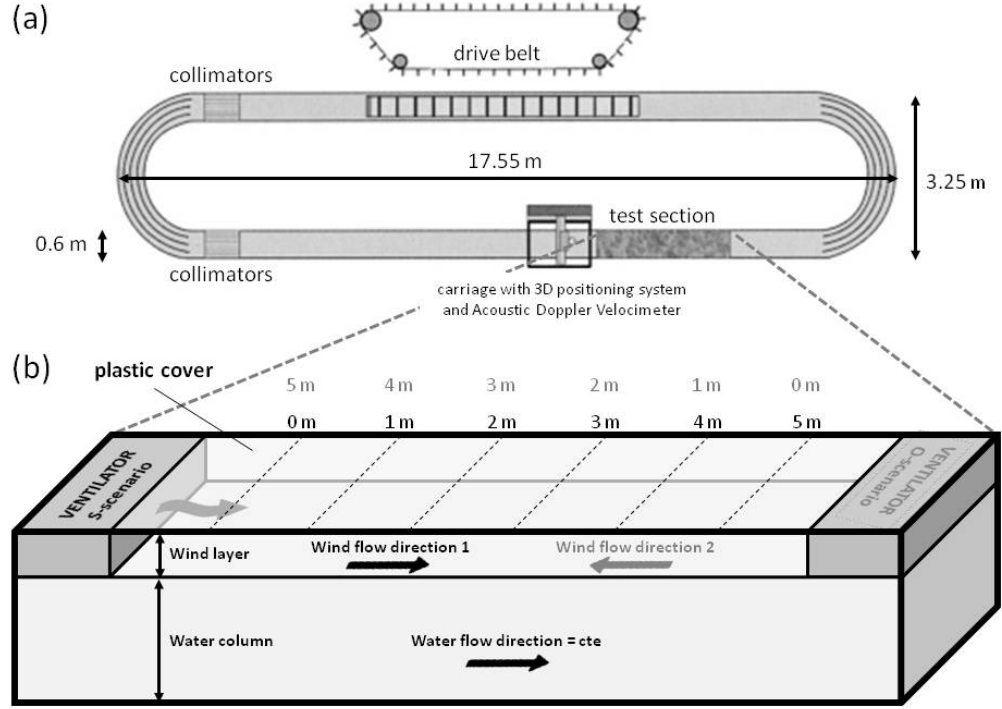
Fig. 1. Schematic representation of (a) the racetrack flume (modified from Bouma et al., 2005) and (b) a detailed depiction of the experimental flume section. (b) The position of the ventilator is indicated in dark grey (left: S-scenario; right: O-scenario). The wind flow direction 1 represents the S-scenario (black arrows, numbers and text), where the O-scenario setup is shown as wind direction 2 (grey arrows, numbers and text). Dispersal time was measured at intervals of one meter (see dotted